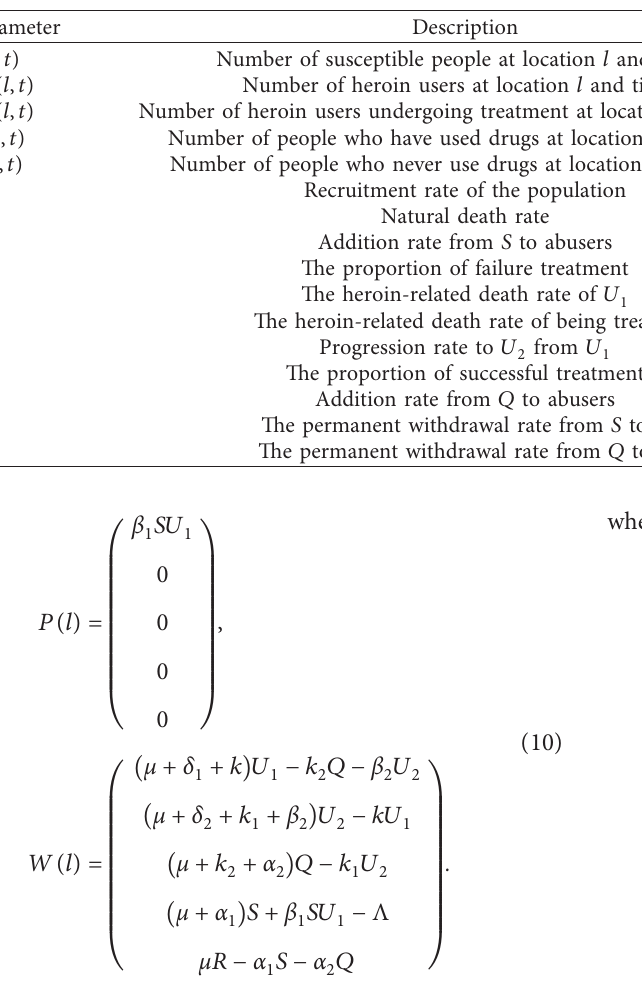
Table 1: Description of